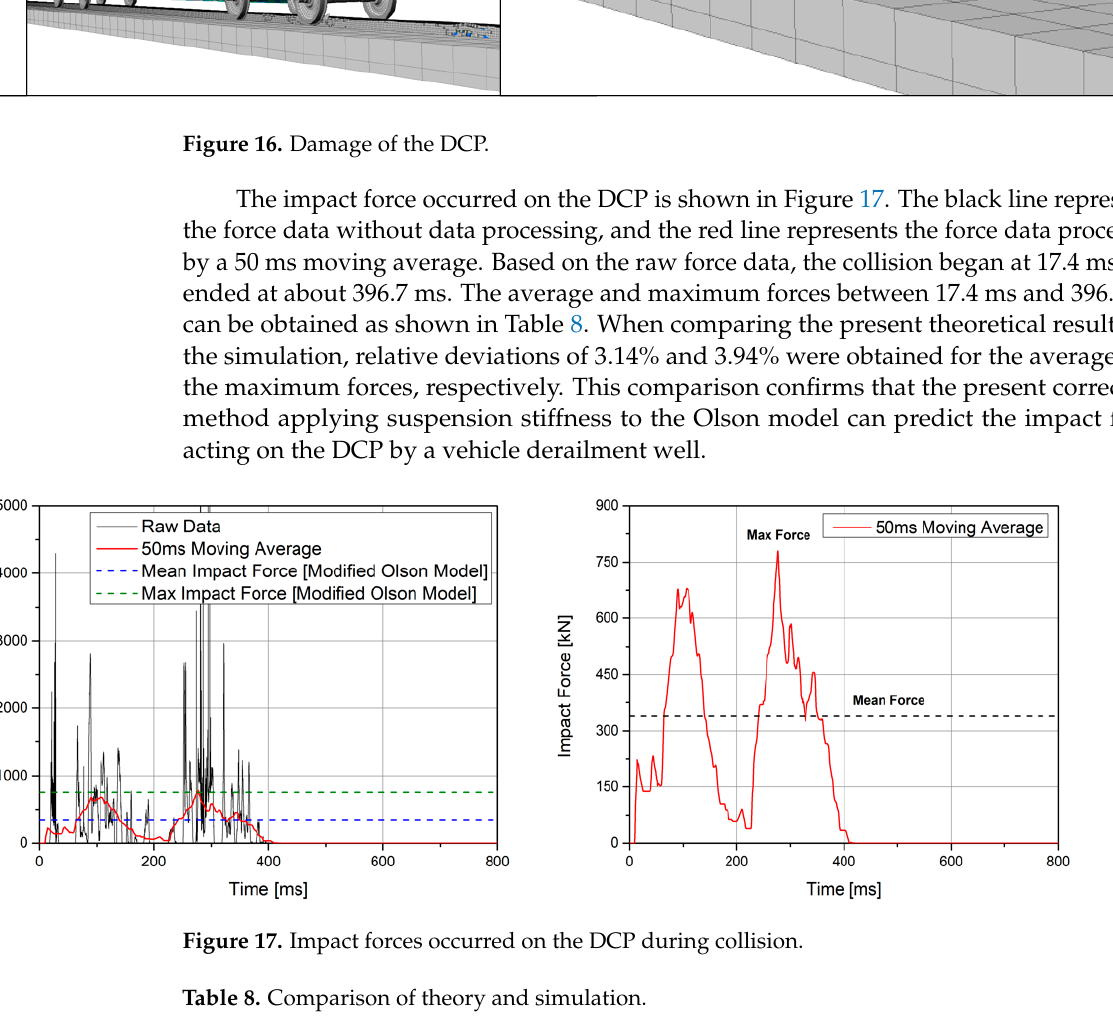
Figure 16. Damage of the DCP.